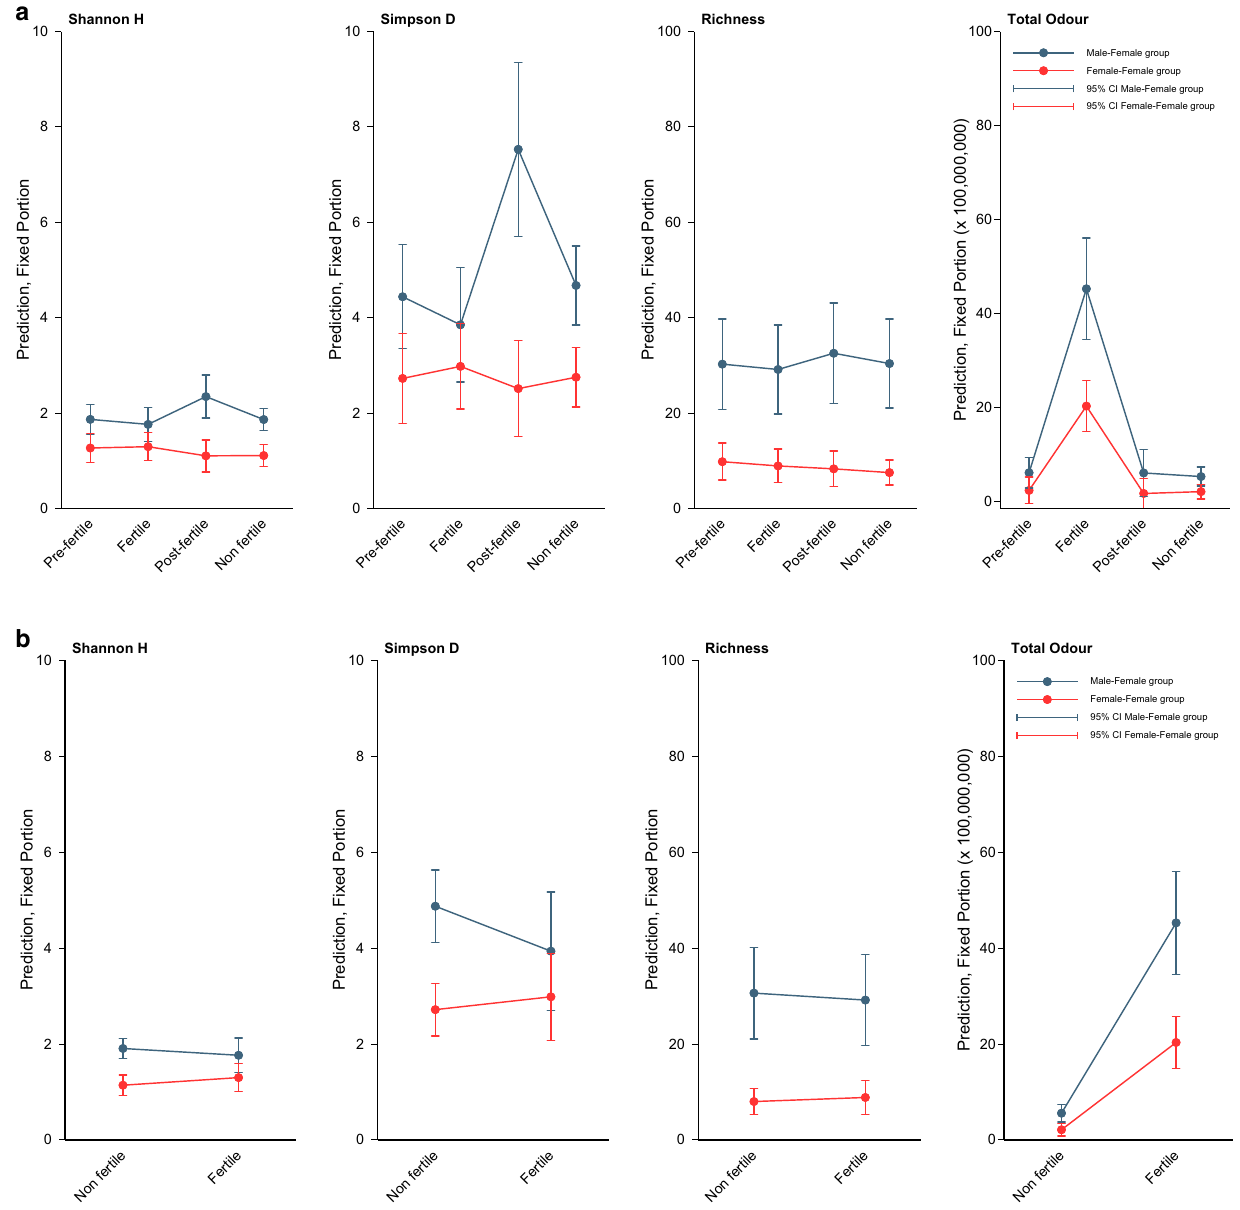
Figure 5. Predictions of the three diversity indices and of Total Odour by using GLMM estimates of the fixed